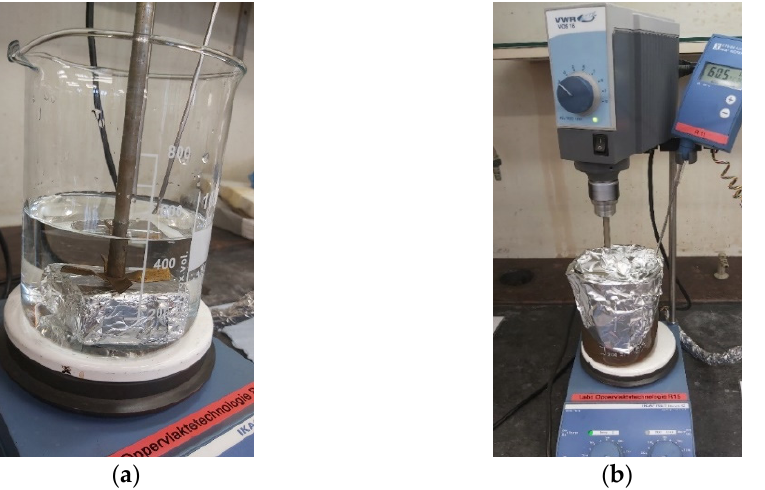
Figure 7. Set-up of the wet magnetic separation process: ( a ) at the beginning of the experiment and ( b ) during the process (temperature 60 °C).